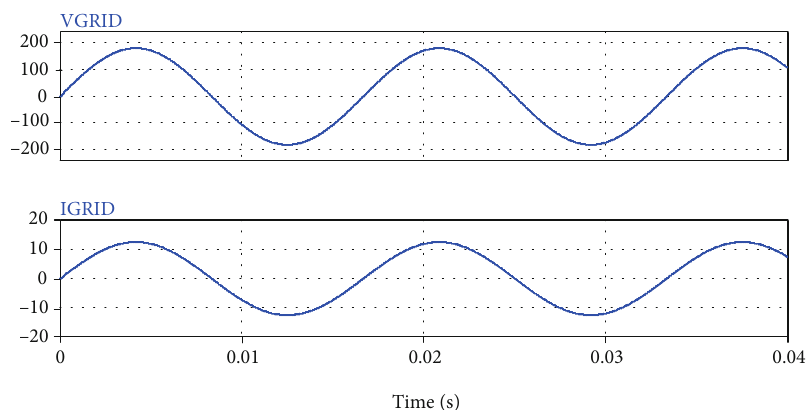
Figure 11: Active power injection to the grid. (a, b) Filter output voltage (100V/div) and fi lter output current (10